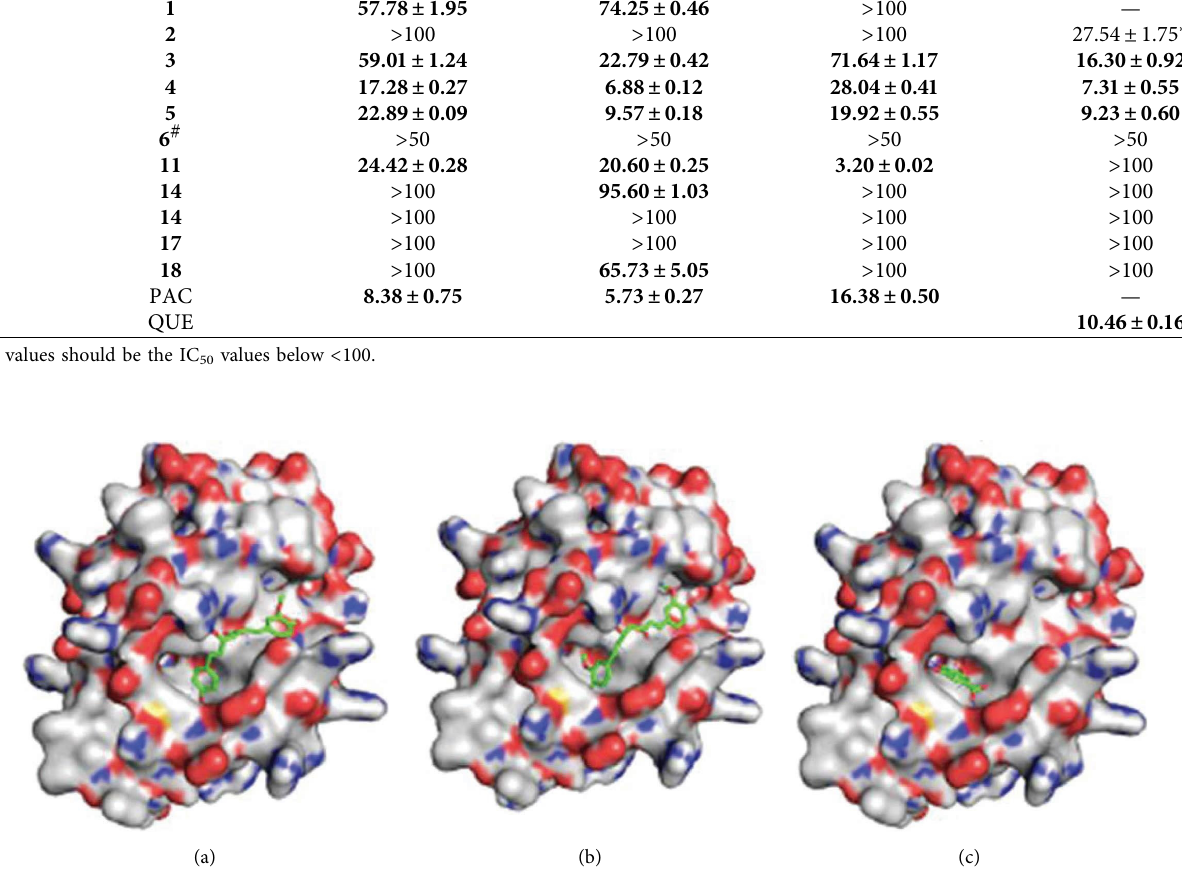
Figure 2: 3D interaction models in the active site of the Bcl-2 protein and compounds 4 (a), 5 (b), and 11 (c).